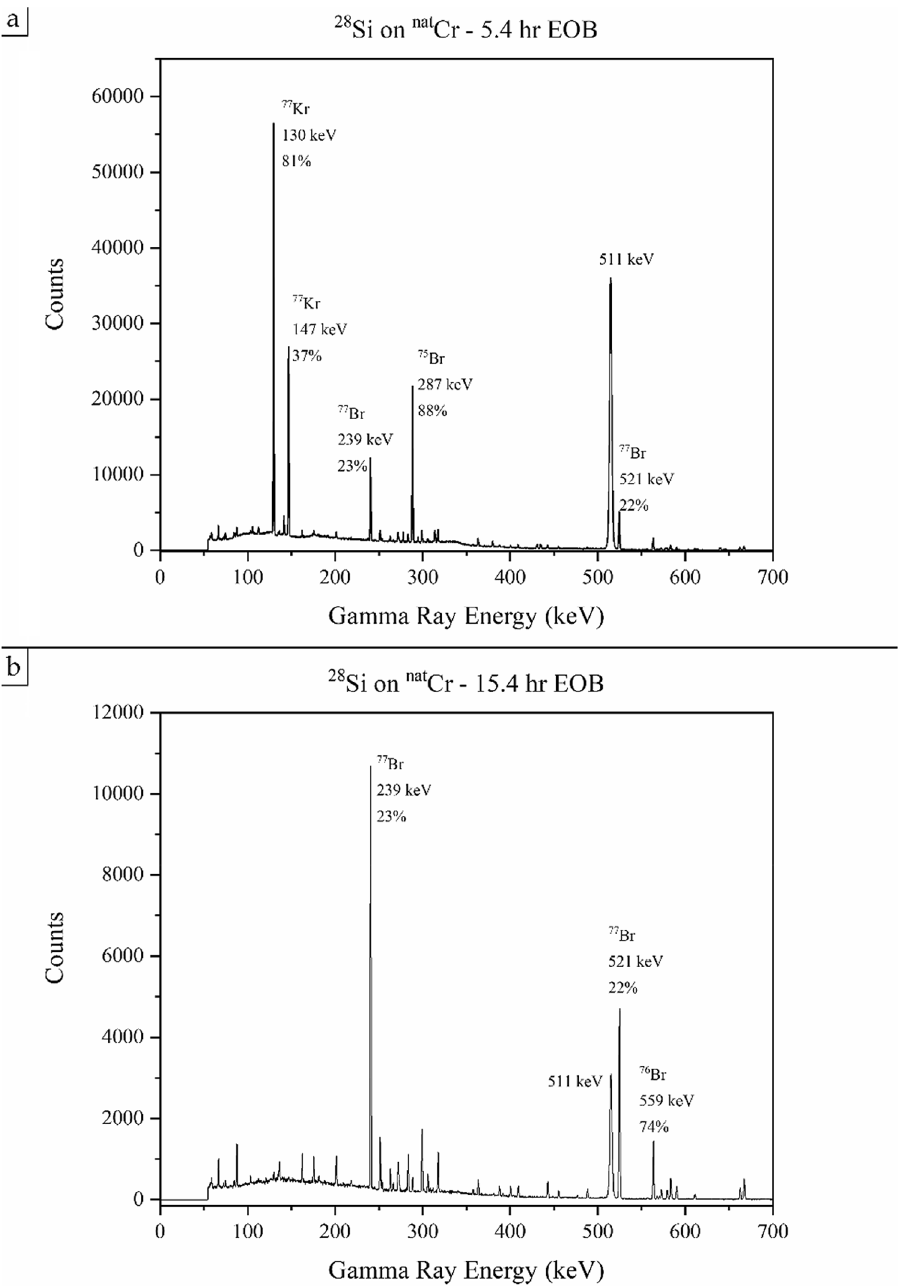
counted for 30 min, beginning 5.4 h EOB (panel a ) or 15.4 h EOB (panel b ). Relevant peaks are labeled with their species of origin, energy and relative intensity 16